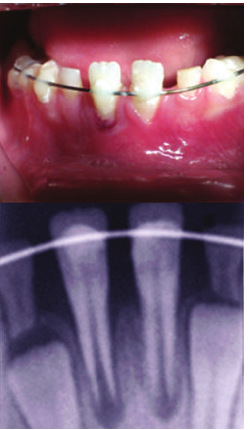
Figure 2: The right lower central incisor was splinted using ortho- dontic